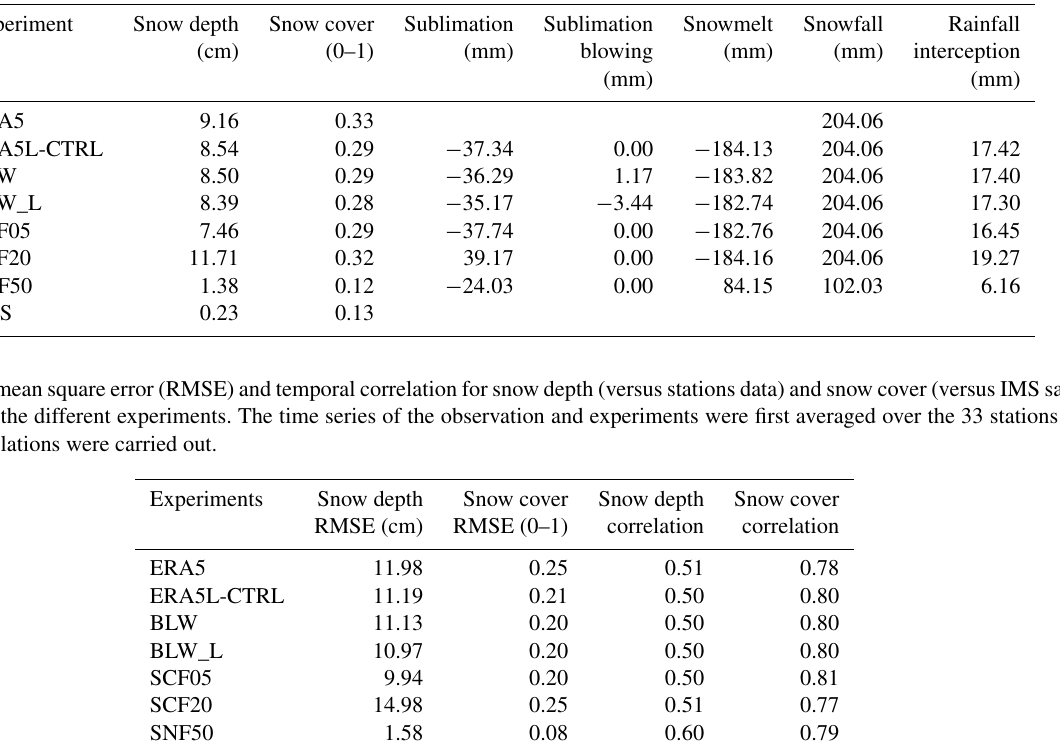
Table 5. ERA5 and offline ERA5-Land experiments mean annual snow and associated fluxes averaged over the 33 stations. The fluxes are the annual mean accumulation of the following: snow sublimation, snow sublimation due to blowing snow, snowmelt, and snowfall and rainfall intercepted in the snowpack. The last row (OBS) presents the mean snow depth derived from the station data and the mean snow cover from the IMS satellite data (low estimate).